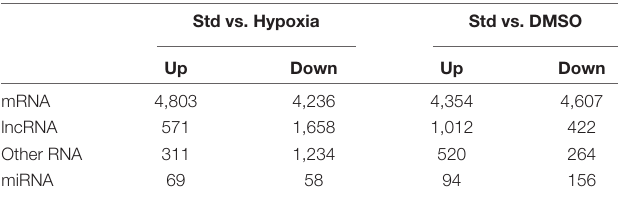
TABLE 1 | The numbers of differentially expressed RNA transcripts in the two experimental sets. Std vs. Hypoxia Std vs.